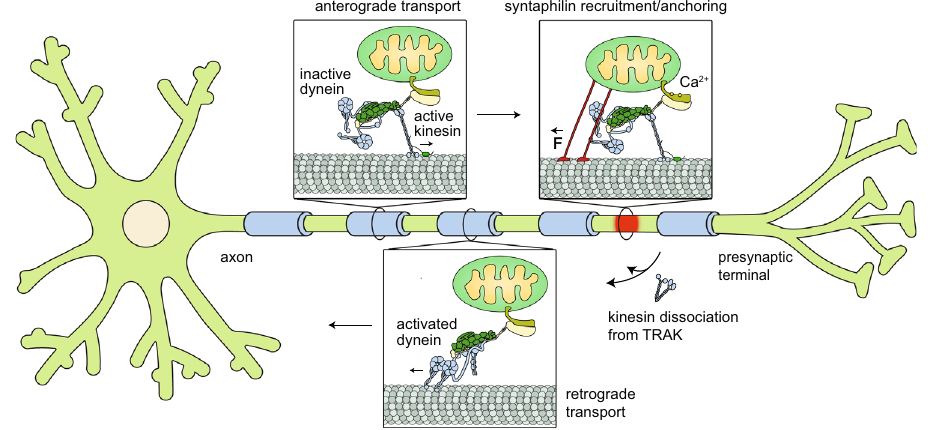
Fig. 8 | A model for bidirectional transport and Ca 2+ -mediated arrest of mito- chondria in neurons. Mitochondria are transported anterogradely by active kinesin motors recruited by TRAK1 while dynein-dynactin is transported as an inactive passenger. In regions with high Ca 2+ concentration (red), mitochondria